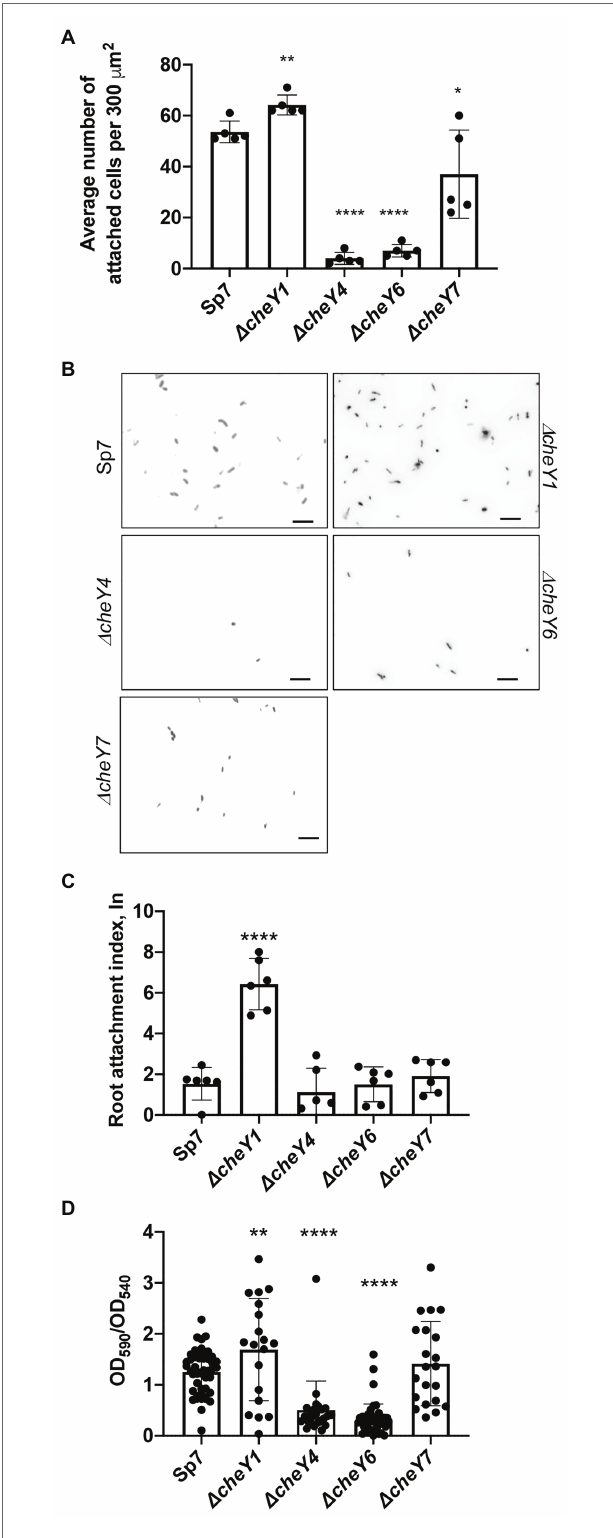
FIGURE 8 | Azospirillum brasilense wild type and cheY mutant strains attachment to abiotic and biotic surfaces and biofilm